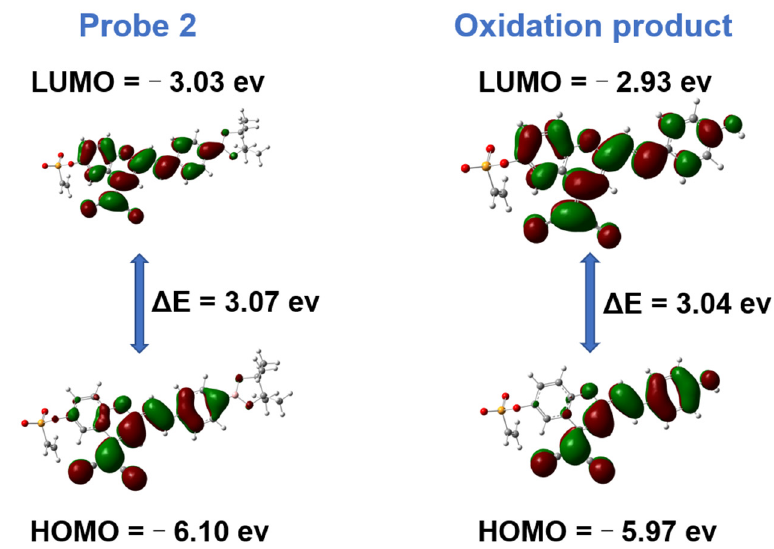
Figure 7. Density functional theory calculation for mechanistic study.